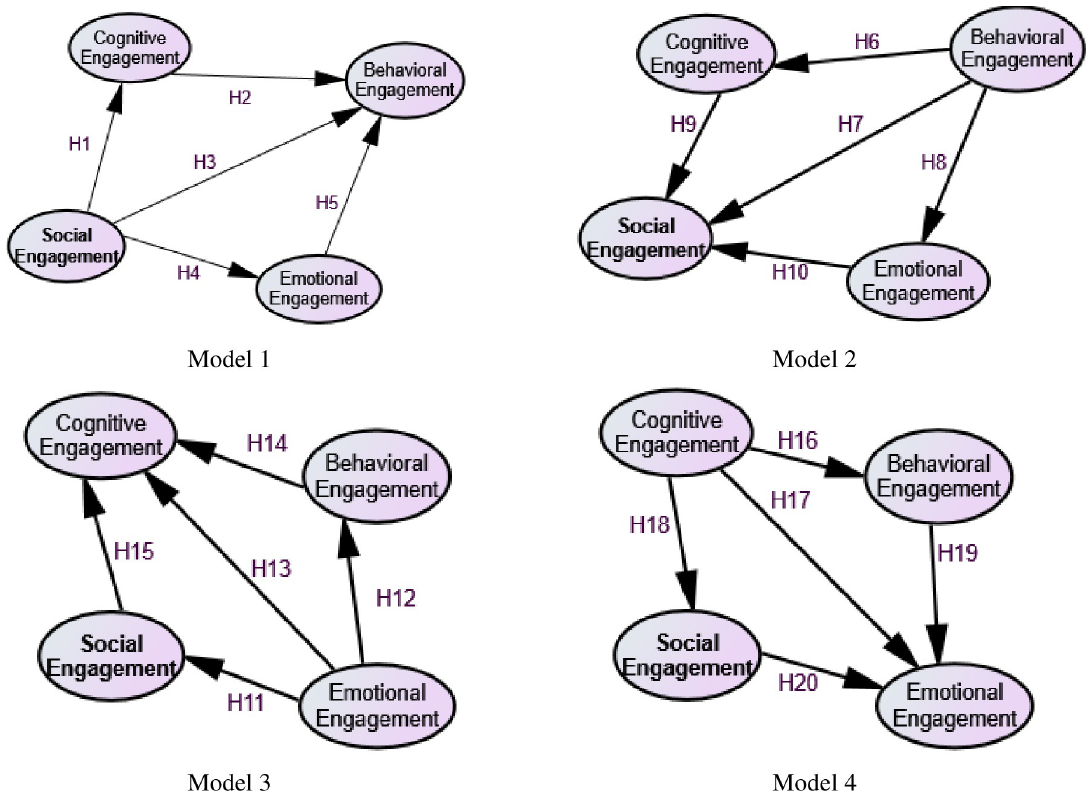
Fig 2. Conceptual framework (Hypothesized